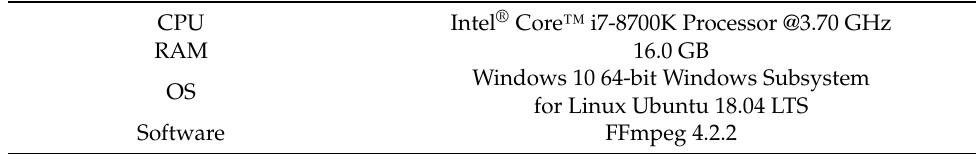
Figure 8. A block diagram for performance evaluation.